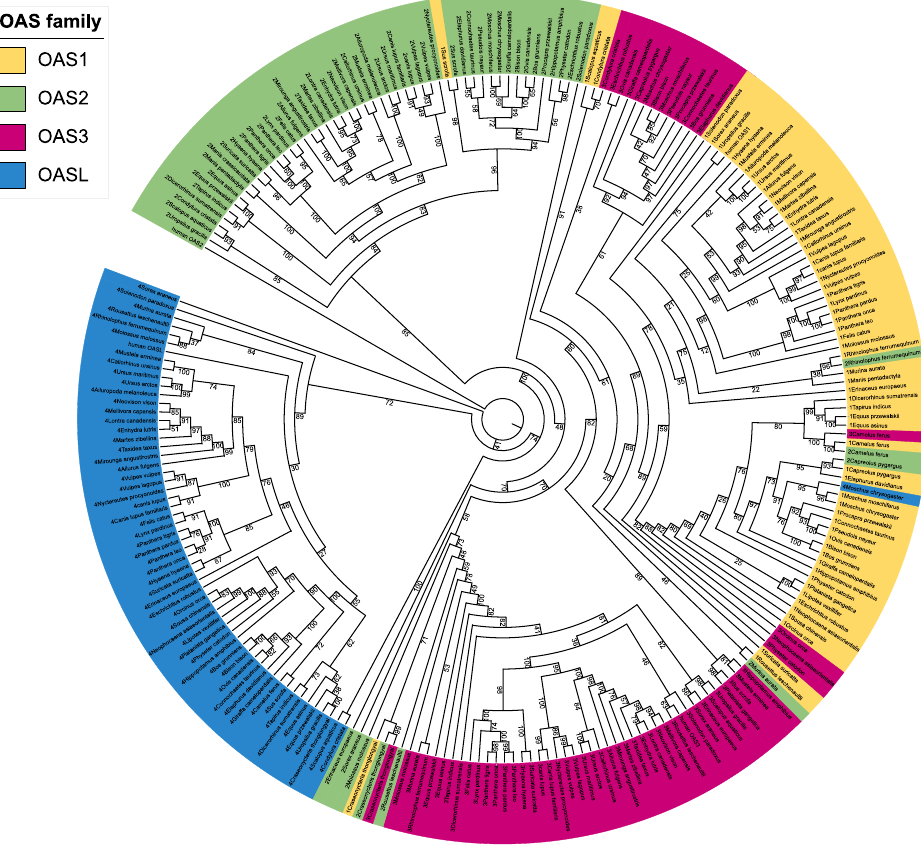
Figure 2. Phylogenetic tree of the OAS genes in Laurasiatherian mammals.